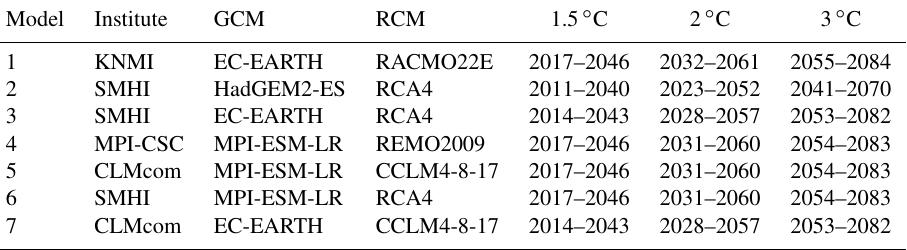
Table 1. EURO-CORDEX climate models used, their characteristics, and the periods of each GCM for the three warming levels considered in this